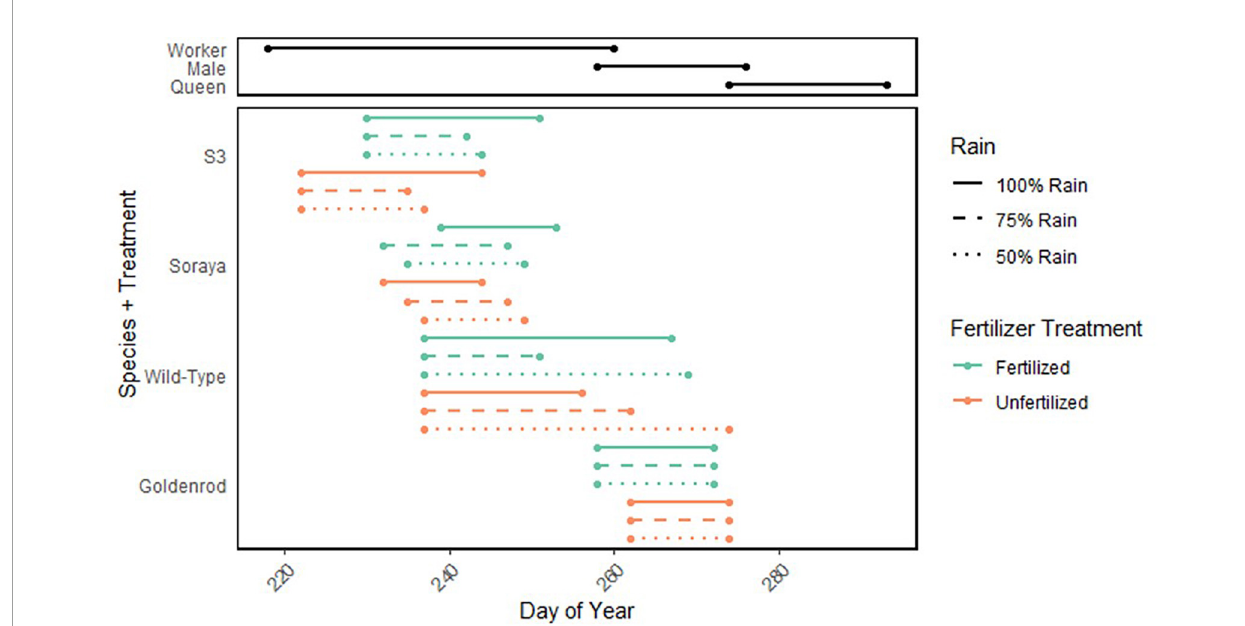
FIGURE6 Activity period for B. impatiens and flowering period of four plant varieties influenced by fertilizer and rain treatments. Black lines represent abundance of B. impatiens workers, males and queens. As lab studies predict, queen development within the nest likely occurred during the male activity period. Green and orange lines represent bloom start and end points at 0.2 and 0.8 quantiles in 2021, color by fertilizer treatment and line style by rain treatment. X -axis represents number day of year, and y -axis represents plant species or variety. We observed 2,950 workers, 1,902 males, and 55 queens. Each goldenrod treatment represents flower counts from approximately 36 plants. Each sunflower treatment represents counts from 12 Soraya, 6–9 S3, and 3–5